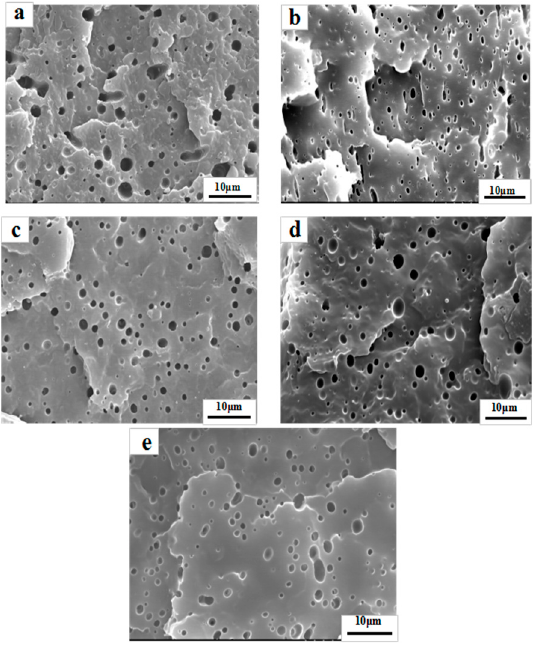
Figure 4. SEM micrographs of the impact fractured surface of the PP/PS blend ( a ) and that using 2 wt.% of compatibilizers (( b ) P1, ( c ) P2, ( d ) P3 and ( e ) SEBS).